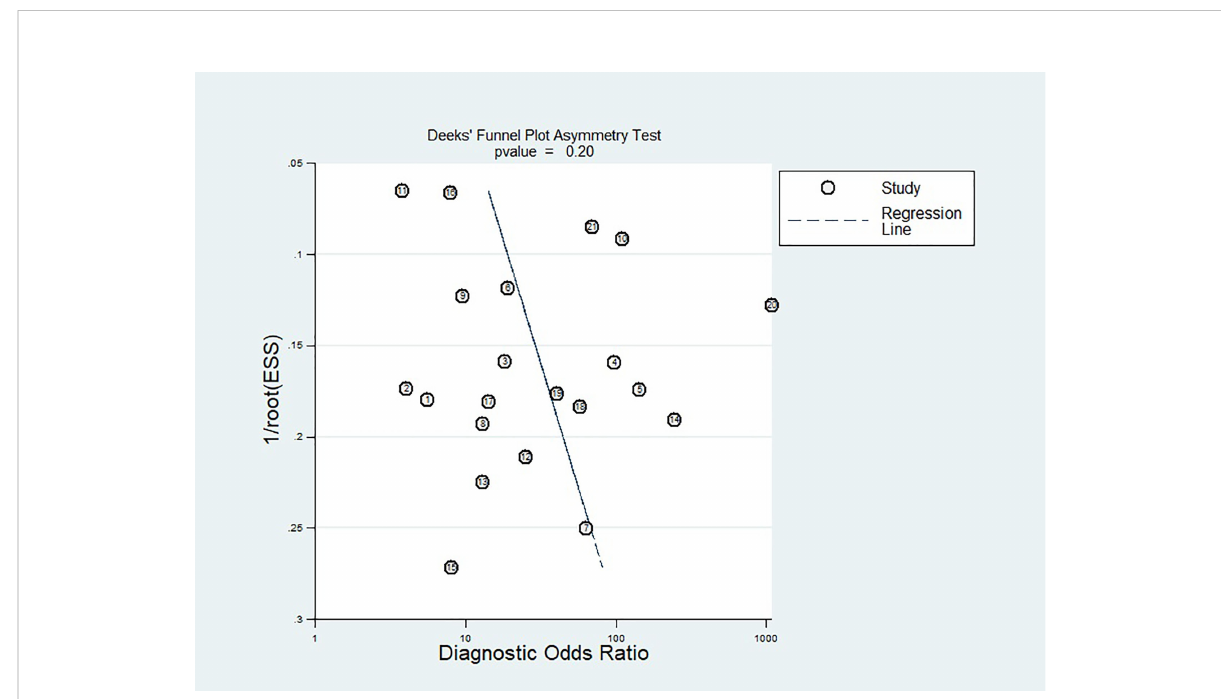
FIGURE 6 Effective sample size (ESS) funnel plots and the associated regression test of asymmetry, as reported by Deeks et al. A p-value < 0.10 was considered evidence of asymmetry and potential publication